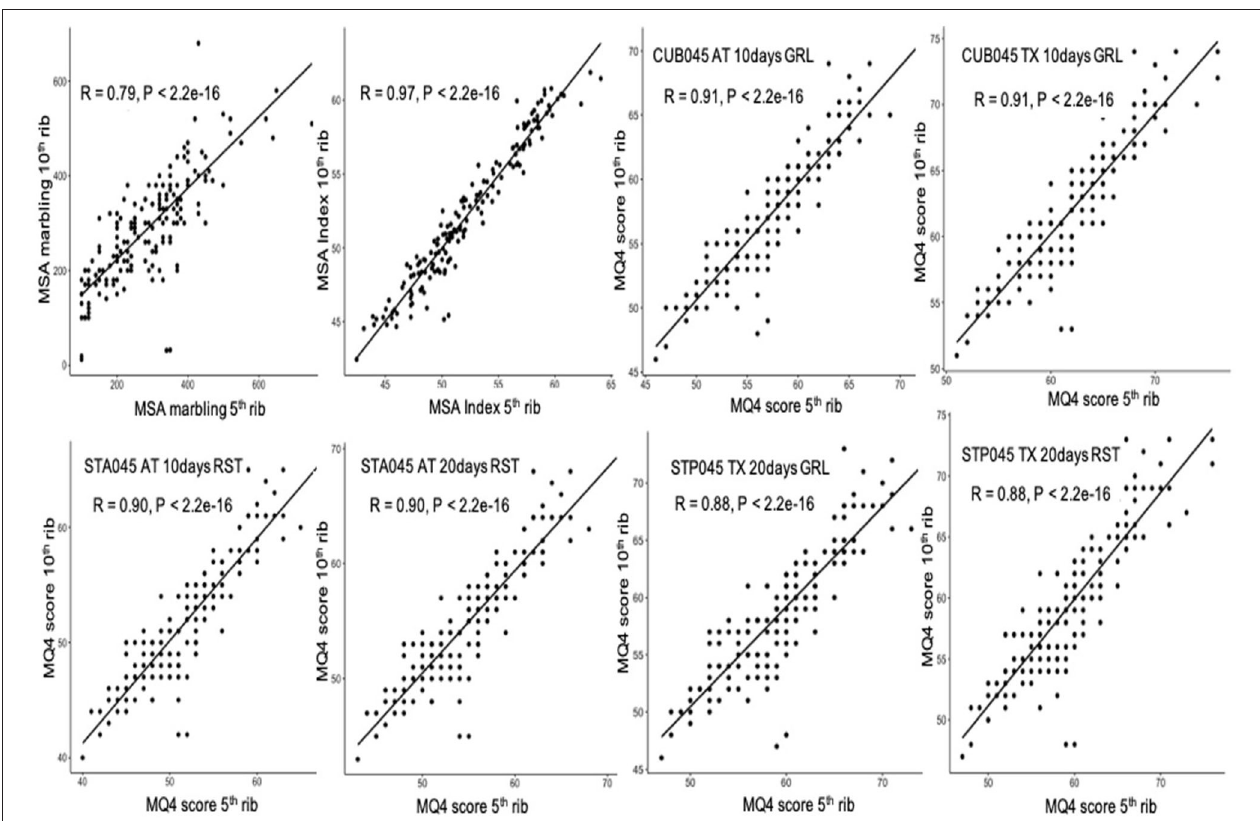
FIGURE 1 | Scatterplots of the Meat Standards Australia (MSA) index and meat quality (MQ4) scores with inputs of marbling scores from the fifth rib (x-axis) or the tenth rib (y-axis). CUB045, M. longissimus thoracis ; STA045, M. longissimus thoracis et lumborum , anterior striploin piece; STP045, M. longissimus thoracis et lumborum , posterior striploin piece; AT, hang method—Achilles tendon; TX, hang method: tenderstretch; 10 days, 10 days aging; 20 days, 20 days aging; GRL, cooking method—grill; and RST, cooking method—roast.